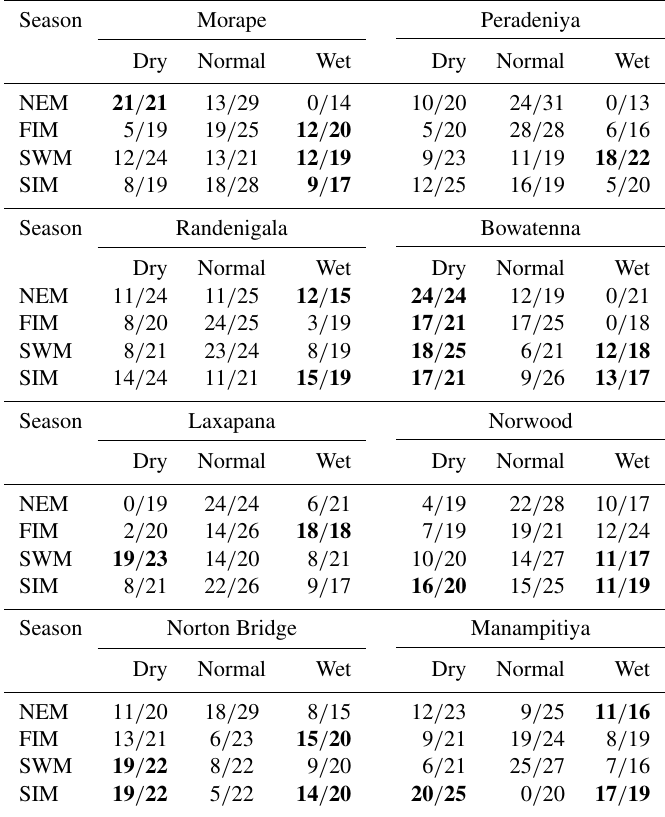
Table A3. Classification tree model results. Highlighted cells indicate where there may be information content with respect to forecasting either dry or wet anomaly